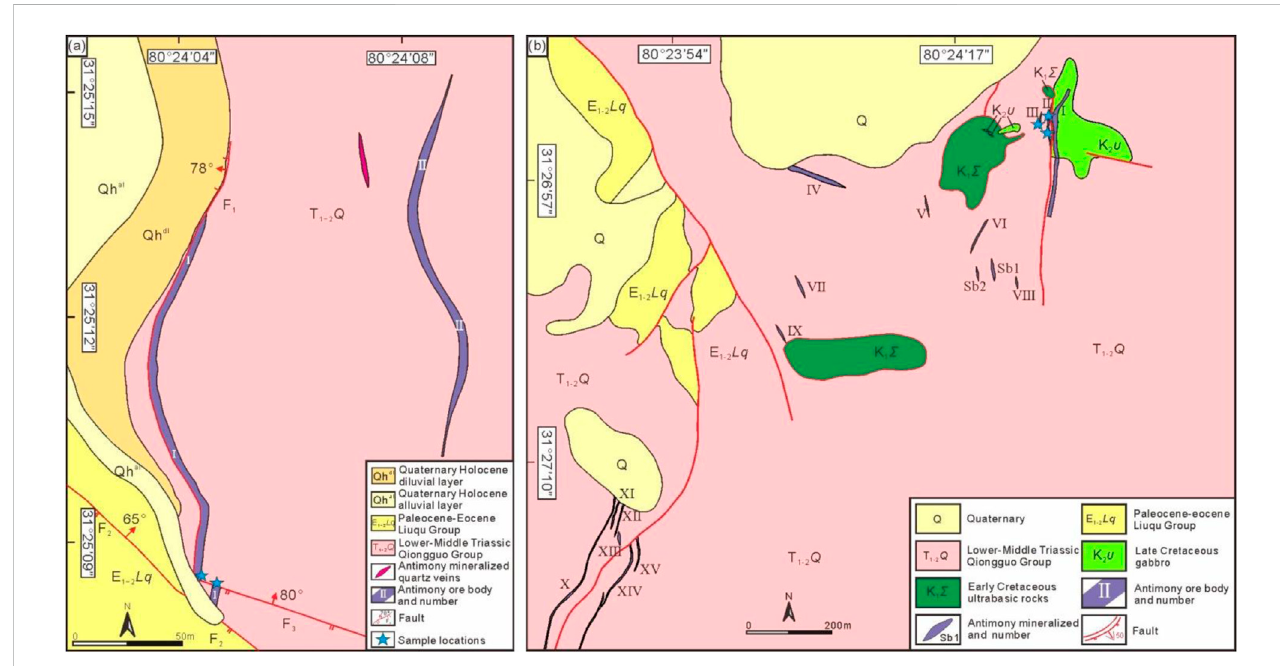
FIGURE 3 Geological maps of Hamuqu (A) and Quzhen (B) antimony deposits (Fang et al., 2006; Chen et al.,